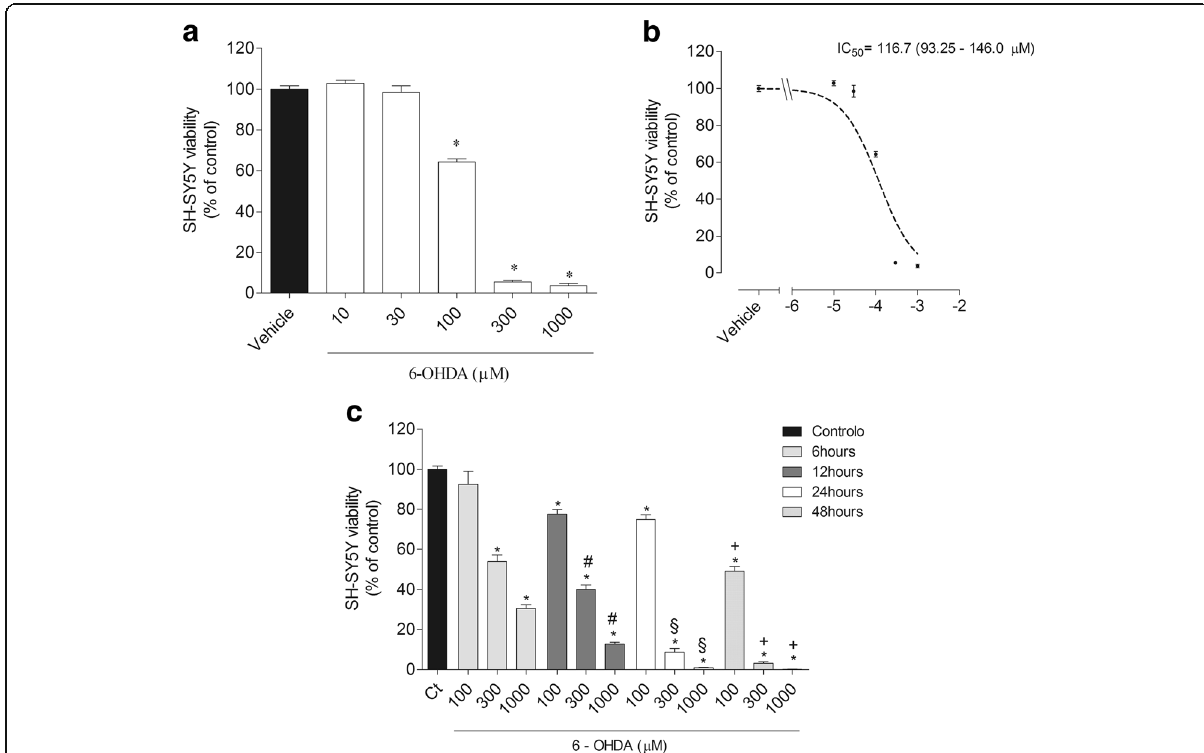
Fig. 1 Concentration dependent effect of 6-OHDA (10 – 1000 μ M) on SH-SY5Y cells viability (% of control) after 24 h of incubation ( a ); IC 50 obtained from different concentrations of 6-OHDA (100-1000 μ M) ( b ); Effect of 6 - OHDA (100 – 1000 μ M) on SH-SY5Y cells viability (% of control) after different times of incubation 6, 12, 24 and 48 h ( c ). Results were obtained by the MTT method. Values are mean±SEM ( n =16). Symbols represent statistically significant differences ( p <0.05, ANOVA, Tukey test) when compared to: *vehicle; # 6 h; § 12 h; + 24 h